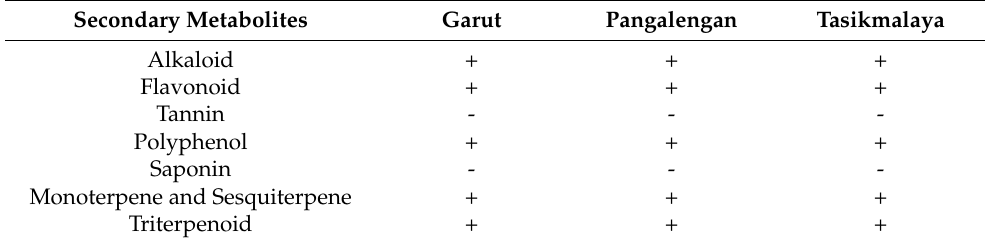
Table 1. Phytochemical screening results. Secondary